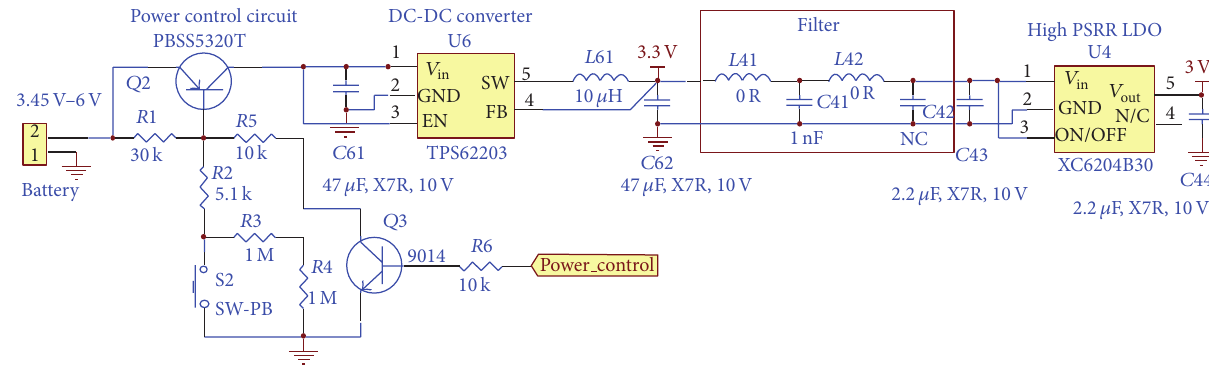
Figure 1: ANODE power management circuit.